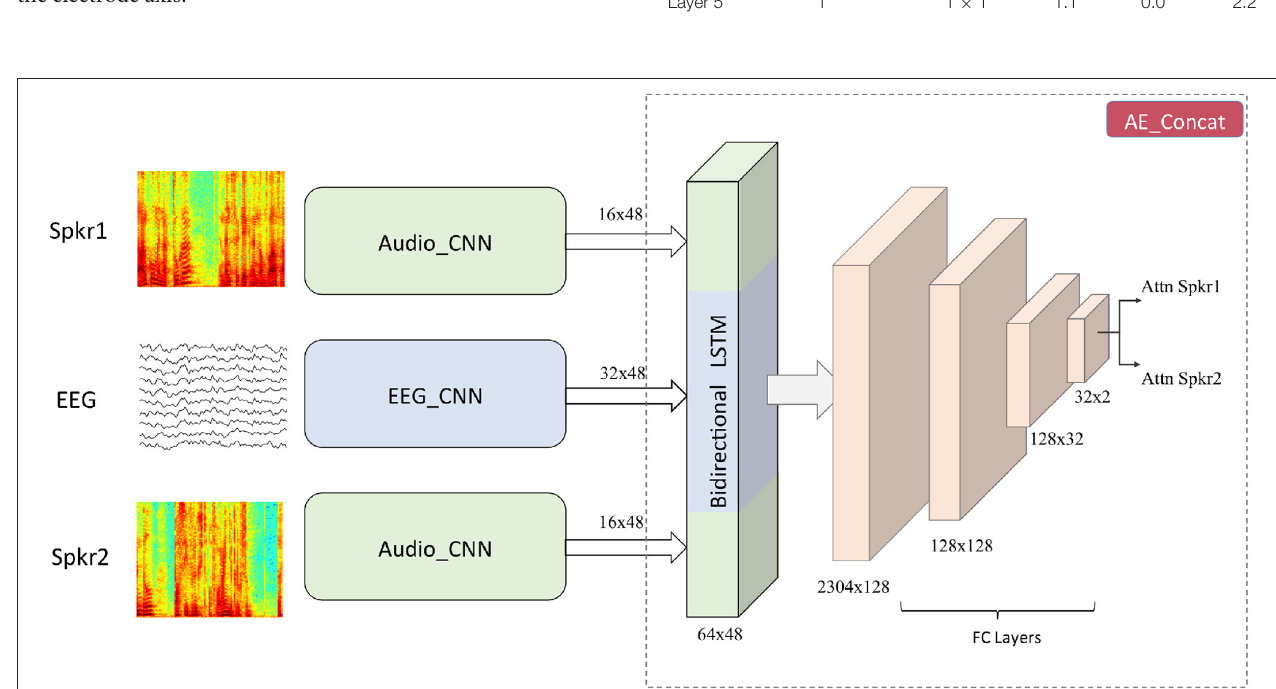
FIGURE 1 | The architecture of the proposed joint CNN-LSTM model. Input to the audio stream is the spectrogram of speech signals and input to the EEG stream is the downsampled version of EEG signals. Number of Audio_CNNs depends on the number of speakers present in the auditory scene (here two). From the outputs of Audio_CNN and EEG_CNN, speech and EEG embeddings are created which are concatenated together and passed to a BLSTM layer followed by FC layers.